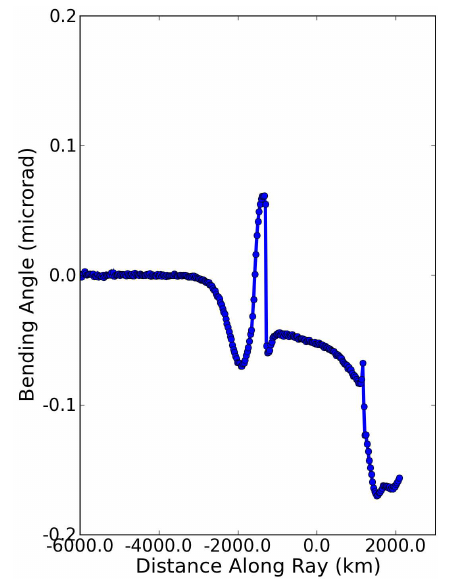
Fig. 5. Residual bending angle after the dual-frequency correction is applied, IRI case.